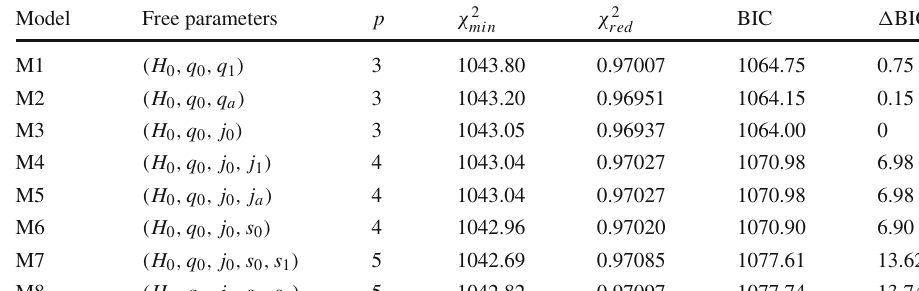
Table 4 Intervals for the adopted flat priors for each parameter and parametrization